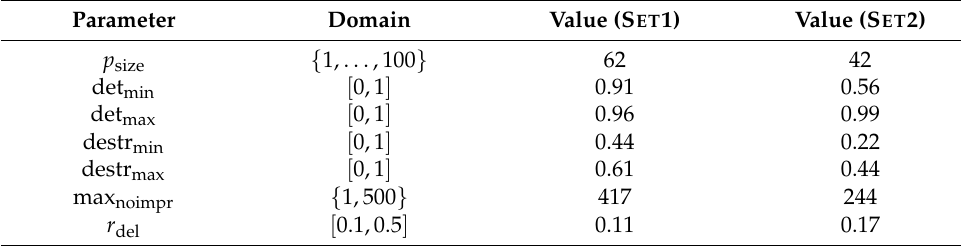
Table 1. Parameters, value domains, and values chosen for PBIG by irace